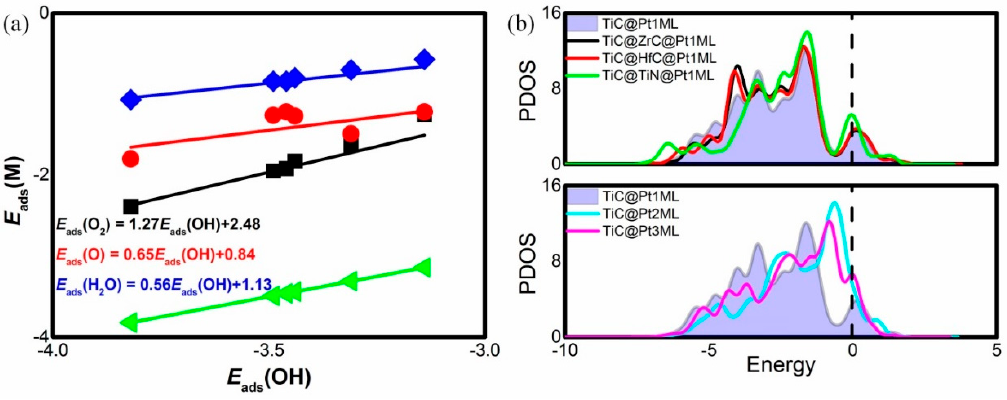
Figure 2. ( a ) The adsorption energy E ads of the ORR intermediates as a function of E ads (OH); and ( b ) the partial density of states (PDOS) for the Pt surface atoms.